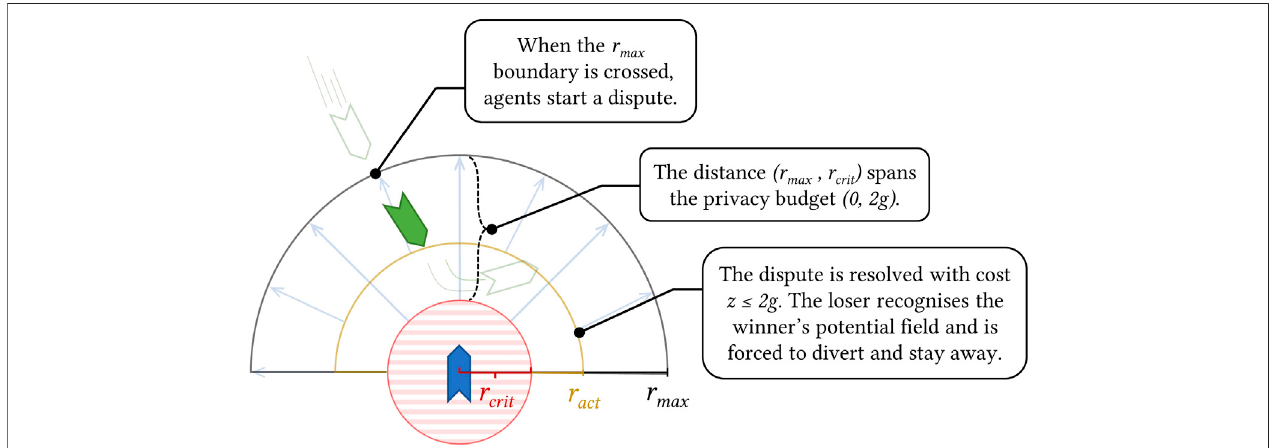
FIGURE 5 | Illustration of the collision avoidance mechanism from De fi nition 6.1.